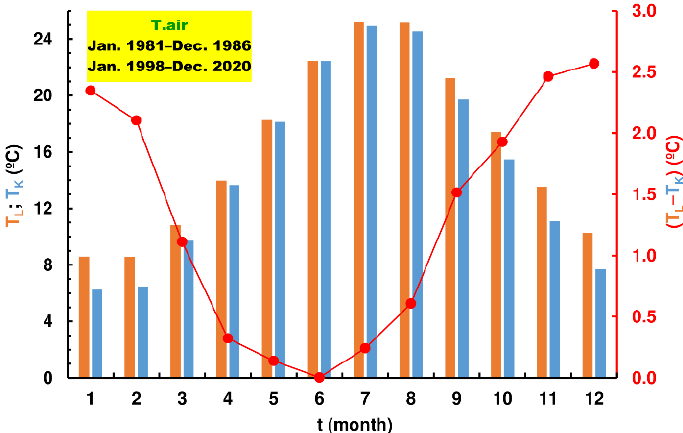
Figure 4. Histograms of the average values of the mean monthly air temperatures at Lastovo (brown) and Krk (blue) and their differences (red) in the period 1981 – 1986 and 1998 – 2020. From the ratio of mean monthly air temperatures of Lastovo (ordinate axis) and Krk